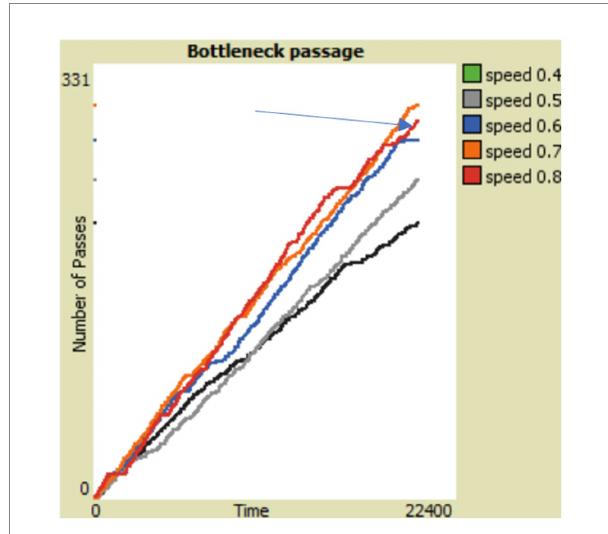
FIGURE 2 A graph showing the faster-is-slower effect to the number of passes increase with speed from 0.4 to 0.7, but then it decreases for 0.8. The arrow shows that the number of passes is lower for the red curve, than for the orange